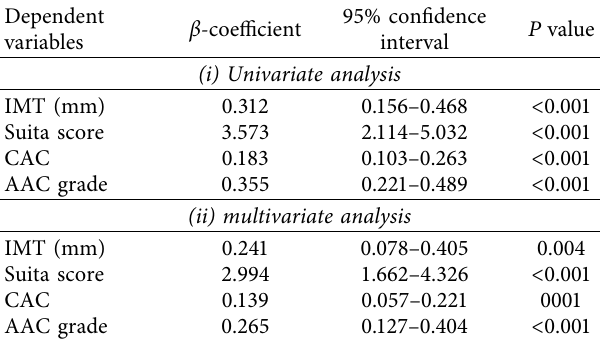
Table 3: Univariate or multivariate linear regression analysis predicting the association between FIB4 index, IMT, suita score, IMT calcification, and AAC